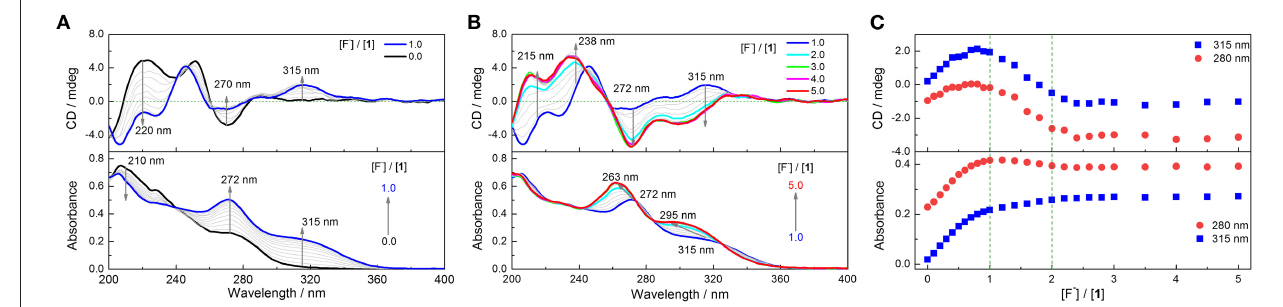
FIGURE 4 | (A) Schematic representation of osmotic assay for fluoride transport by exerting a concentration gradient of fluoride. Inside LUVs: 100mM KF, 10mM HEPES, pH 7.2. Outside LUVs: 100mM Glc-K, 10mM HEPES, pH 7.2. (B) Normalized fluoride efflux obtained by the addition of compound 1 (50 µ M, 10 mol%) in the presence and absence of Vln (0.5 µ M, 0.1 mol%). At 300s, FCCP (25 µ M, 5 mol%) and Vln (0.5 µ M, 0.1 mol%) (if not added previously) were added to obtain a light scattering intensity corresponding to 100% transport for calibration. (C,D) Hill plot analysis of fluoride efflux when 1 is coupled with Vln (0.5 µ M, 0.1 mol%).